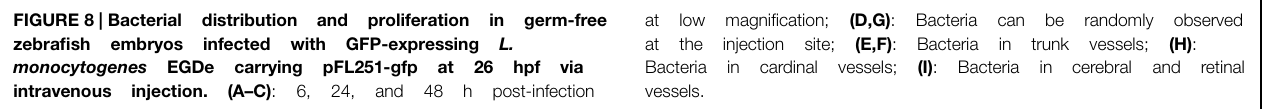
FIGURE 8 | Bacterial distribution and proliferation in germ-free zebrafish embryos infected with GFP-expressing L. monocytogenes EGDe carrying pFL251-gfp at 26 hpf via intravenous injection. (A–C) : 6, 24, and 48 h post-infection